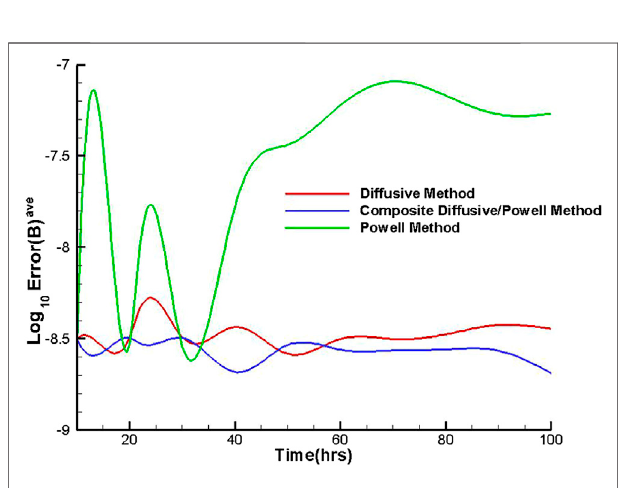
FIGURE8| ThetemporalevolutionoftheLog 10 Error ( B ) ave fromthethree divergence cleaning methods.